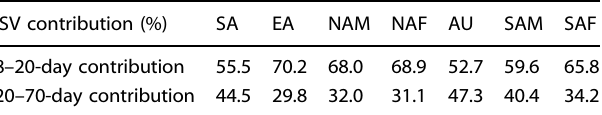
Table 2. Fractional variance of the 8 – 20-day and 20 – 70-day ISVs against the total 8 – 70-day ISV for averaged summer monsoon precipitation over each monsoon